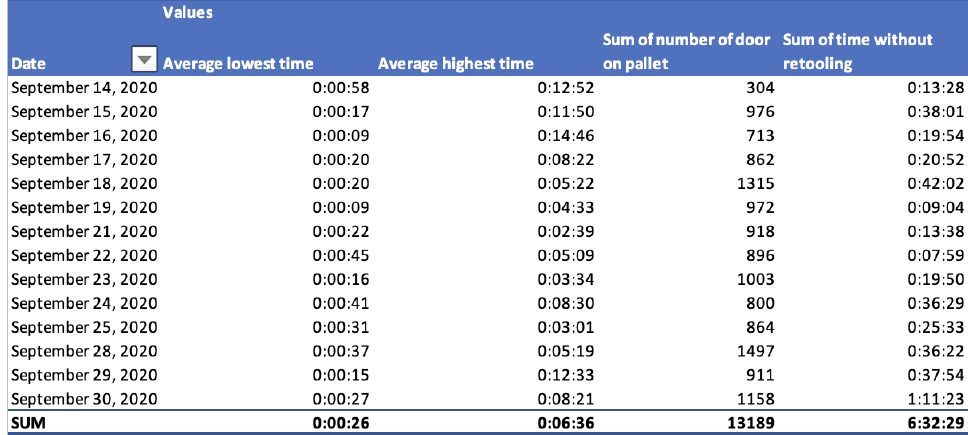
Figure 6. An example of the monthly averaged data.